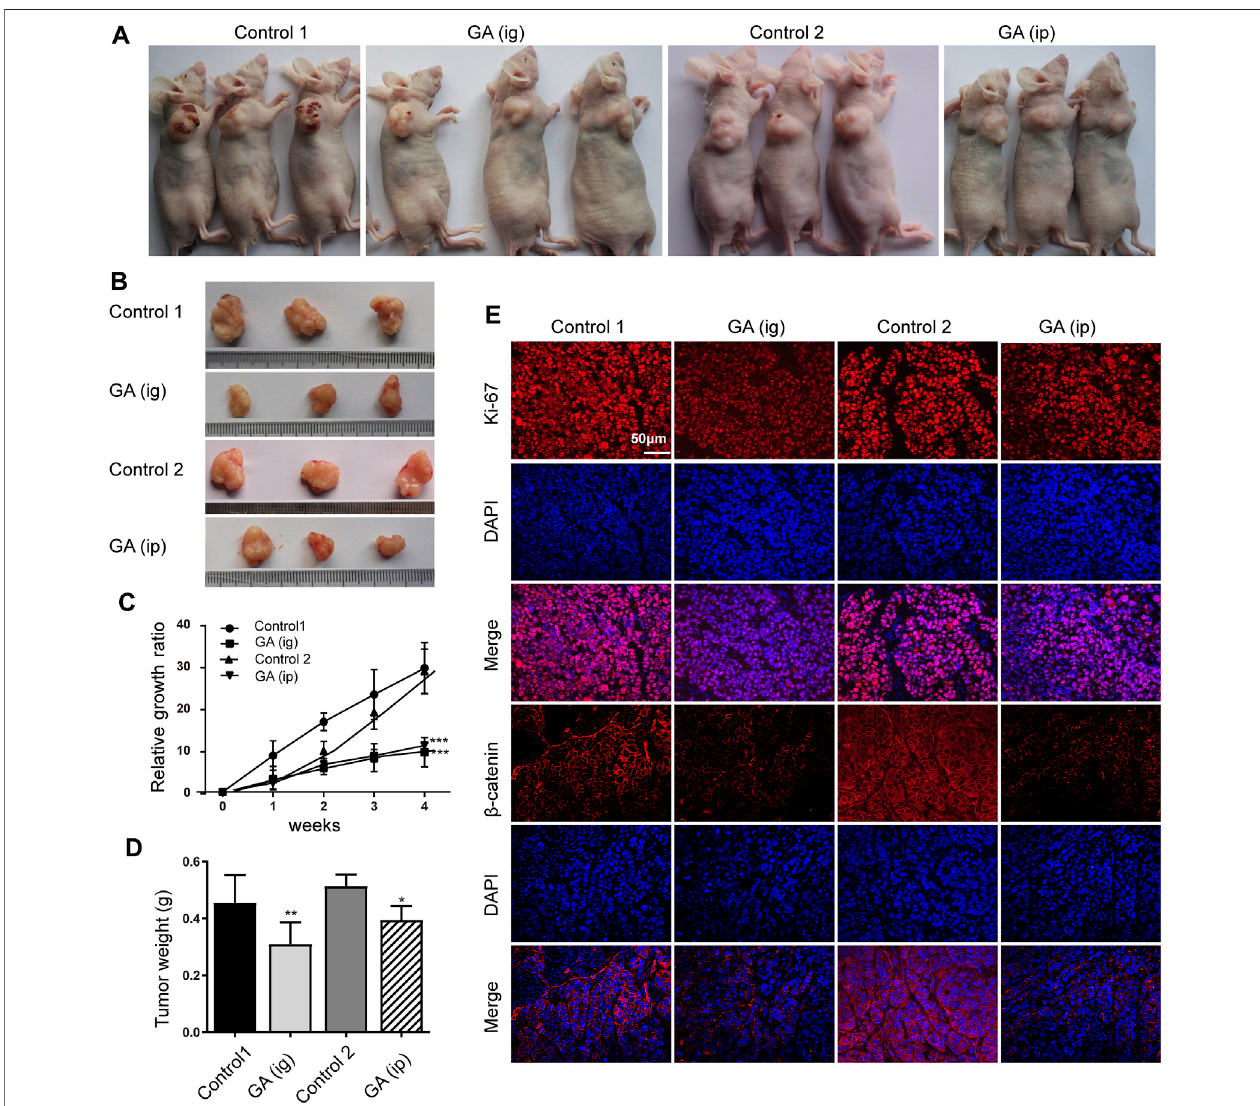
FIGURE 6 | GA reduced the tumor growth of HCC cells in vivo. HepG2 cells were subcutaneously injected into the dorsal fl ank of nude mice, and GA was administrated i. g or i. p . (A,B) The representative images showed smaller tumors in GA treated groups when compared with control groups. (C) The growth curve of tumor volumes. (D) The tumor weight. (E) The immuno fl uorescence of Ki-67 and β -catenin stained sections followed by counterstaining with DAPI. Each data represented the mean ± SEM of six mice. *, p < 0.05; **, p < 0.01; ***, p < 0.001; vs control1 or control 2.